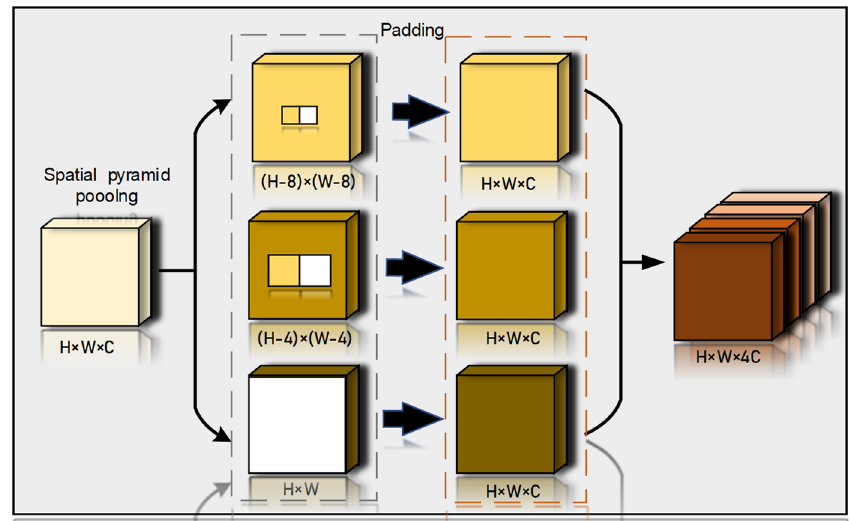
Figure 7. SPP network structure diagram.